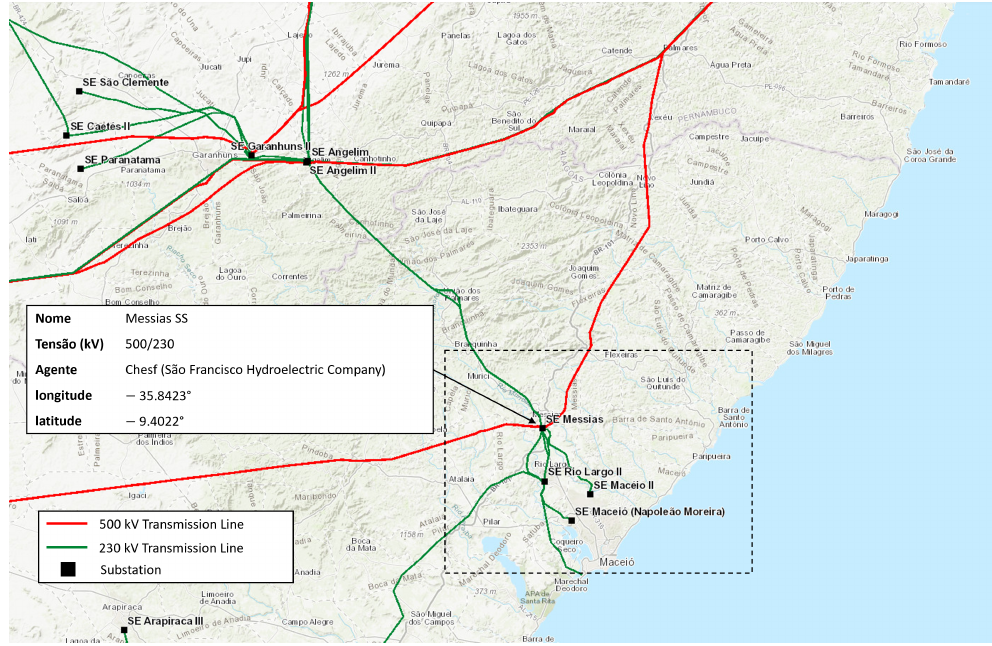
Figure 2. Location of the SS Messias/Chesf